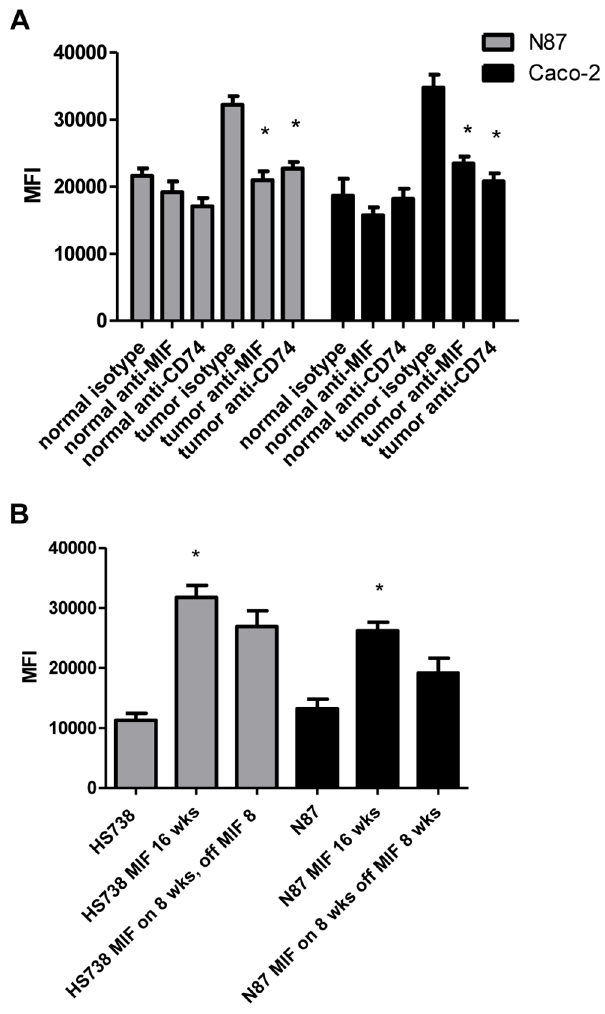
Figure 3. MIF induces proliferation of gastric and colon carcinoma cells. Tumor-derived gastric and colon supernatants induced proliferation of N87 and Caco-2 cells, which was decreased upon adding A) anti-MIF neutralizing antibodies or anti-CD74 blocking antibodies. B) Chronic exposure of HS738 or N87 cells with recombinant MIF increased proliferation that was sustained after returning cells to regular media for 8 weeks. N=8 and the mean 6 standard error are shown as the results of duplicated in multiple experiments. * p ,